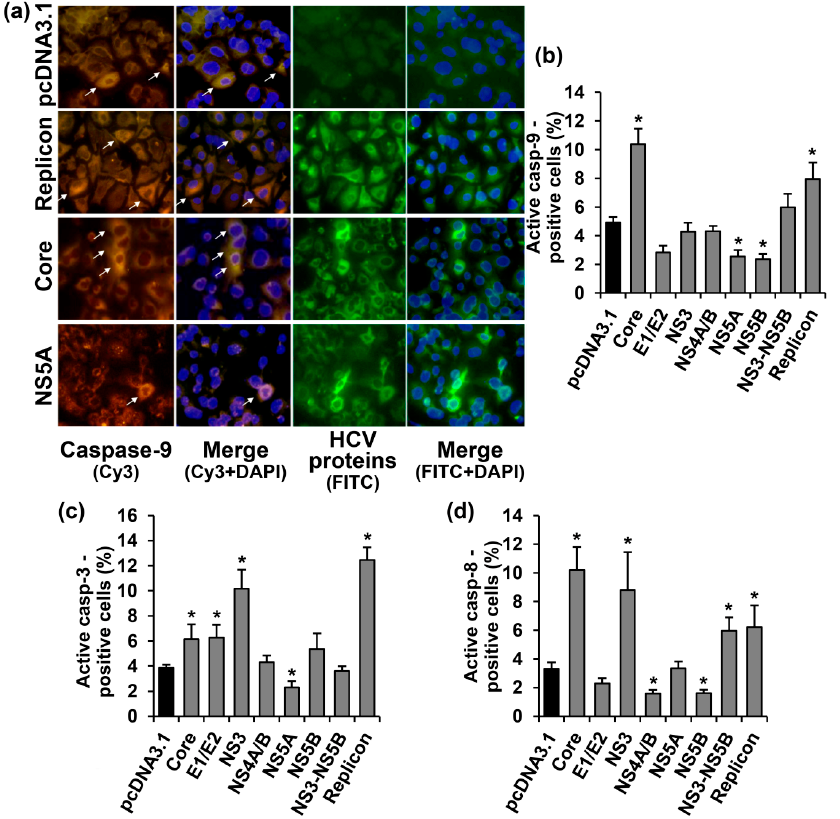
Figure 2. HCV proteins affect activation of caspases-3, -8 and -9 in Huh7.5 cells in different manners. ( a ) Immunofluorescent staining of the activated caspase-9 and HCV proteins in Huh7.5 cells transiently expressing the HCV core or NS5A proteins, or harboring the full-length HCV replicon (400 × magnification). Vertical panels left to right: staining with rabbit anti-caspase-9 primary and anti-rabbit secondary antibodies conjugated to Cy3 (orange), merge with nuclear staining with DAPI (blue), staining with mouse monoclonal antibodies to HCV proteins and anti-mouse secondary antibodies conjugated to fluoresceine isothiocianate (FITC; green), combined with nuclear staining with DAPI (blue). The arrows indicate caspase-9 positive cells. ( b – d ) Percentages of the cells which tested positive for the caspases-9 ( b ), -3 ( c ), and -8 ( d ). Values on each diagram are means ± SEM of eight measurements done in three independent experiments, * p < 0.05 compared to the cells transfected with the empty vector (black